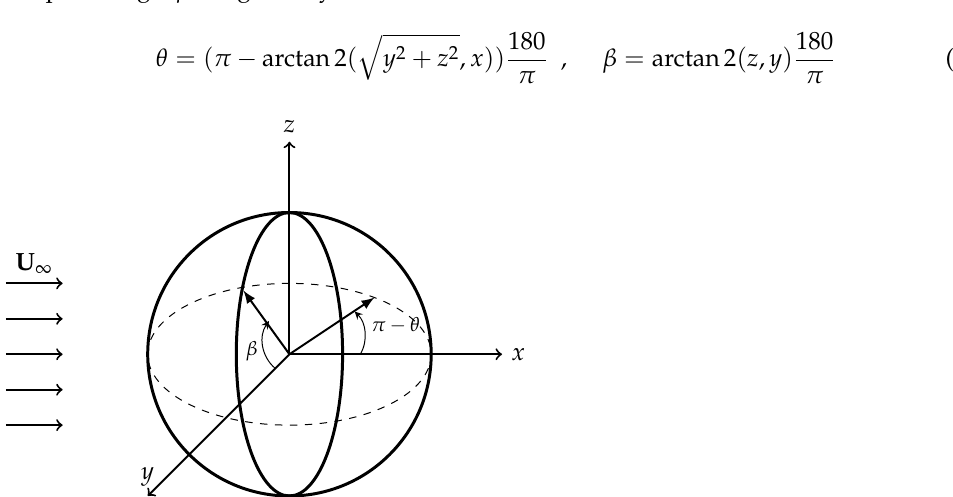
Figure 3. Spherical coordinate system around a particle. The flow direction is represented by the undisturbed velocity U ∞